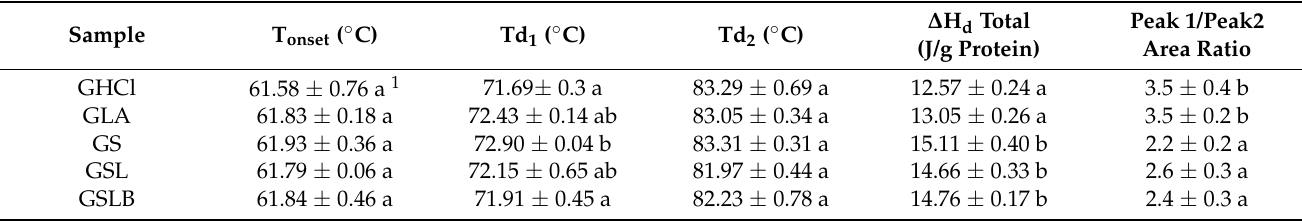
Table 1. Thermal parameters of globulin fractions obtained by lactic fermentation (GS, GSL, GSLB) and controls (GHCl,